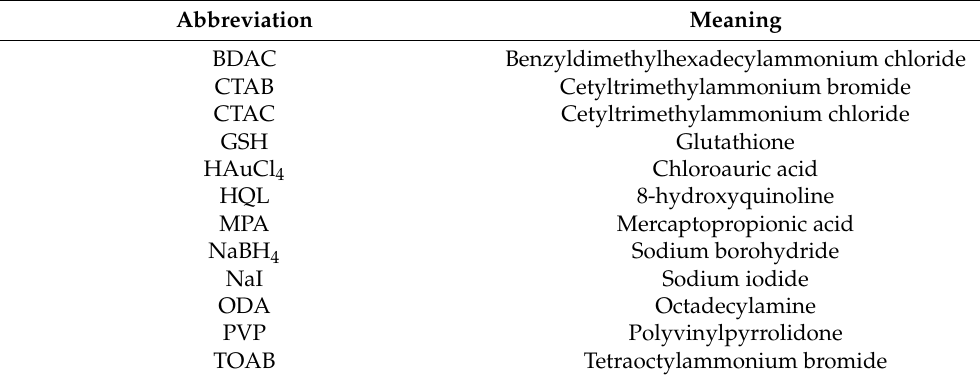
Table 1. Abbreviations for reagents use in AuNP synthesis.